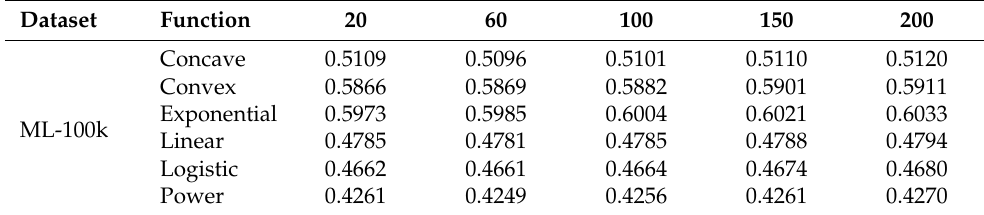
Table 11. MAE Results of Time-Decay Function.